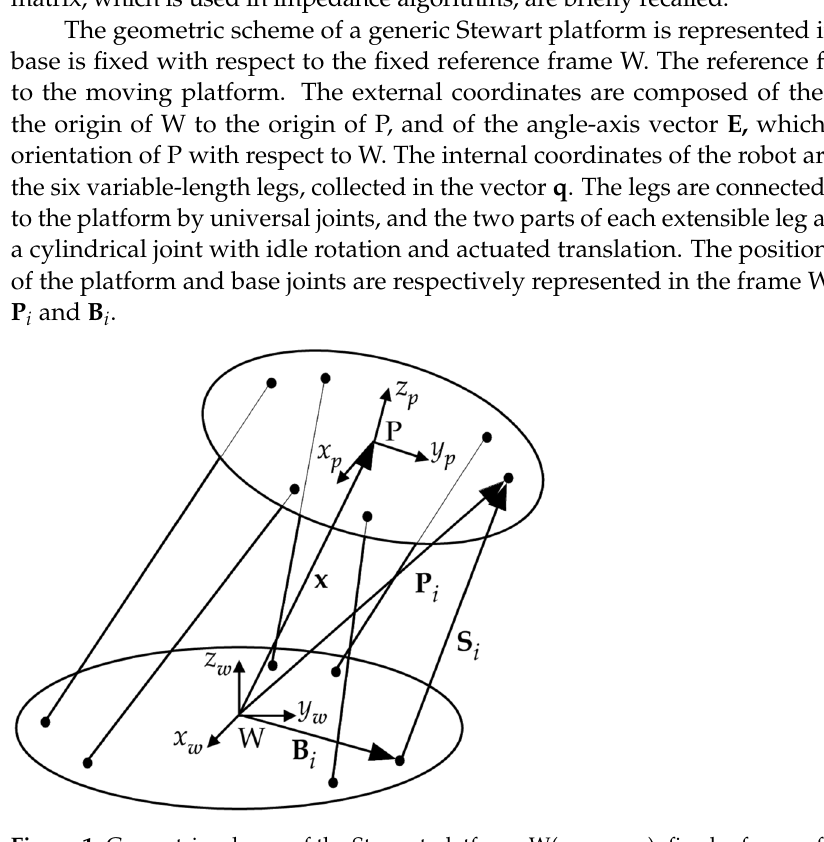
Figure 1. Geometric scheme of the Stewart platform; W( x w , y w ,z w ): fixed reference frame; P( x p , y p ,z p ): moving platform reference frame.